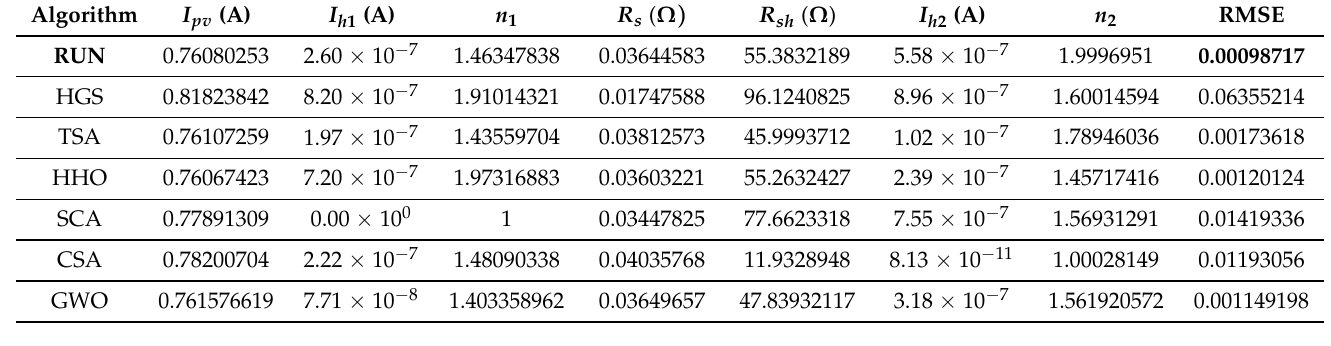
Table 4. The parameters estimated for DDSCM at the optimum RMSE.